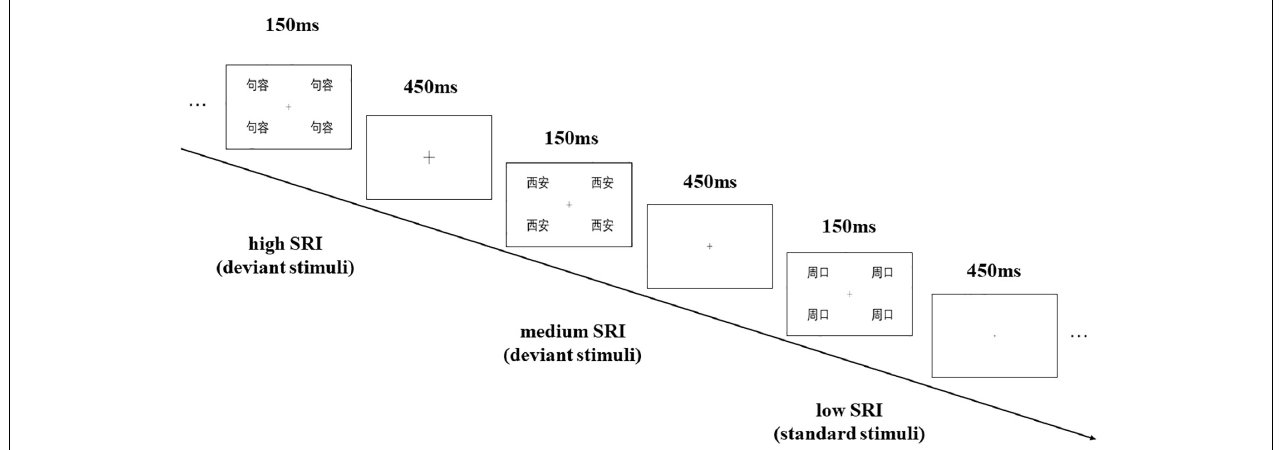
FIGURE 1 | Sample of the visual mismatch negativity (vMMN) procedure with “Jurong” as the participant’s